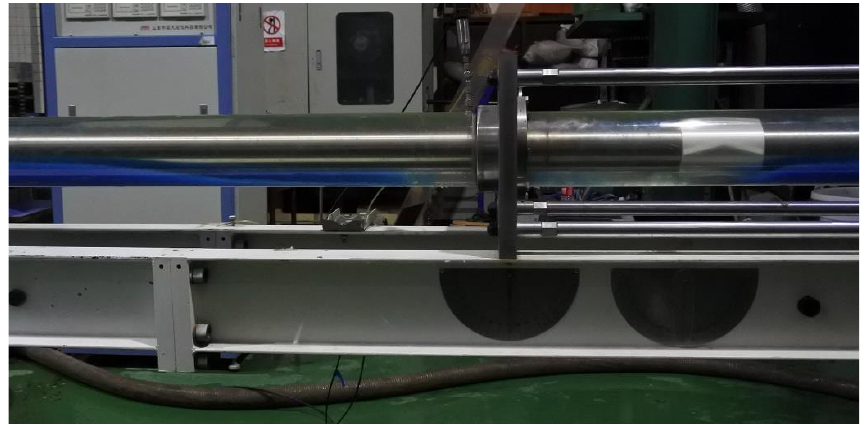
Figure 14. Experimental flow loop used to evaluate effective action distance (back view).